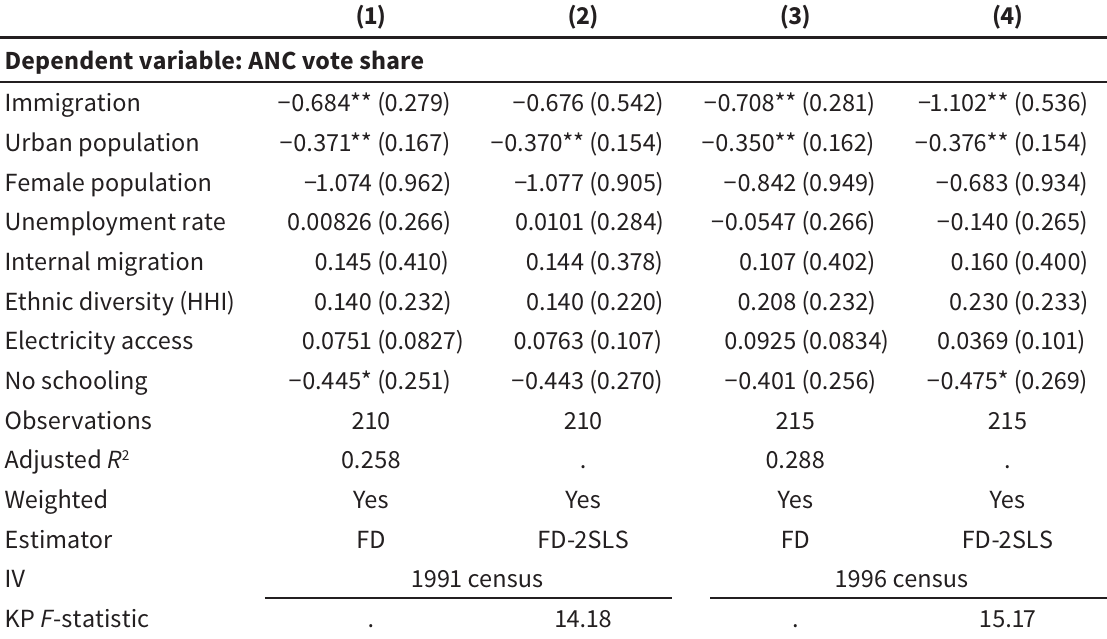
Local election results (1) (2) (3)